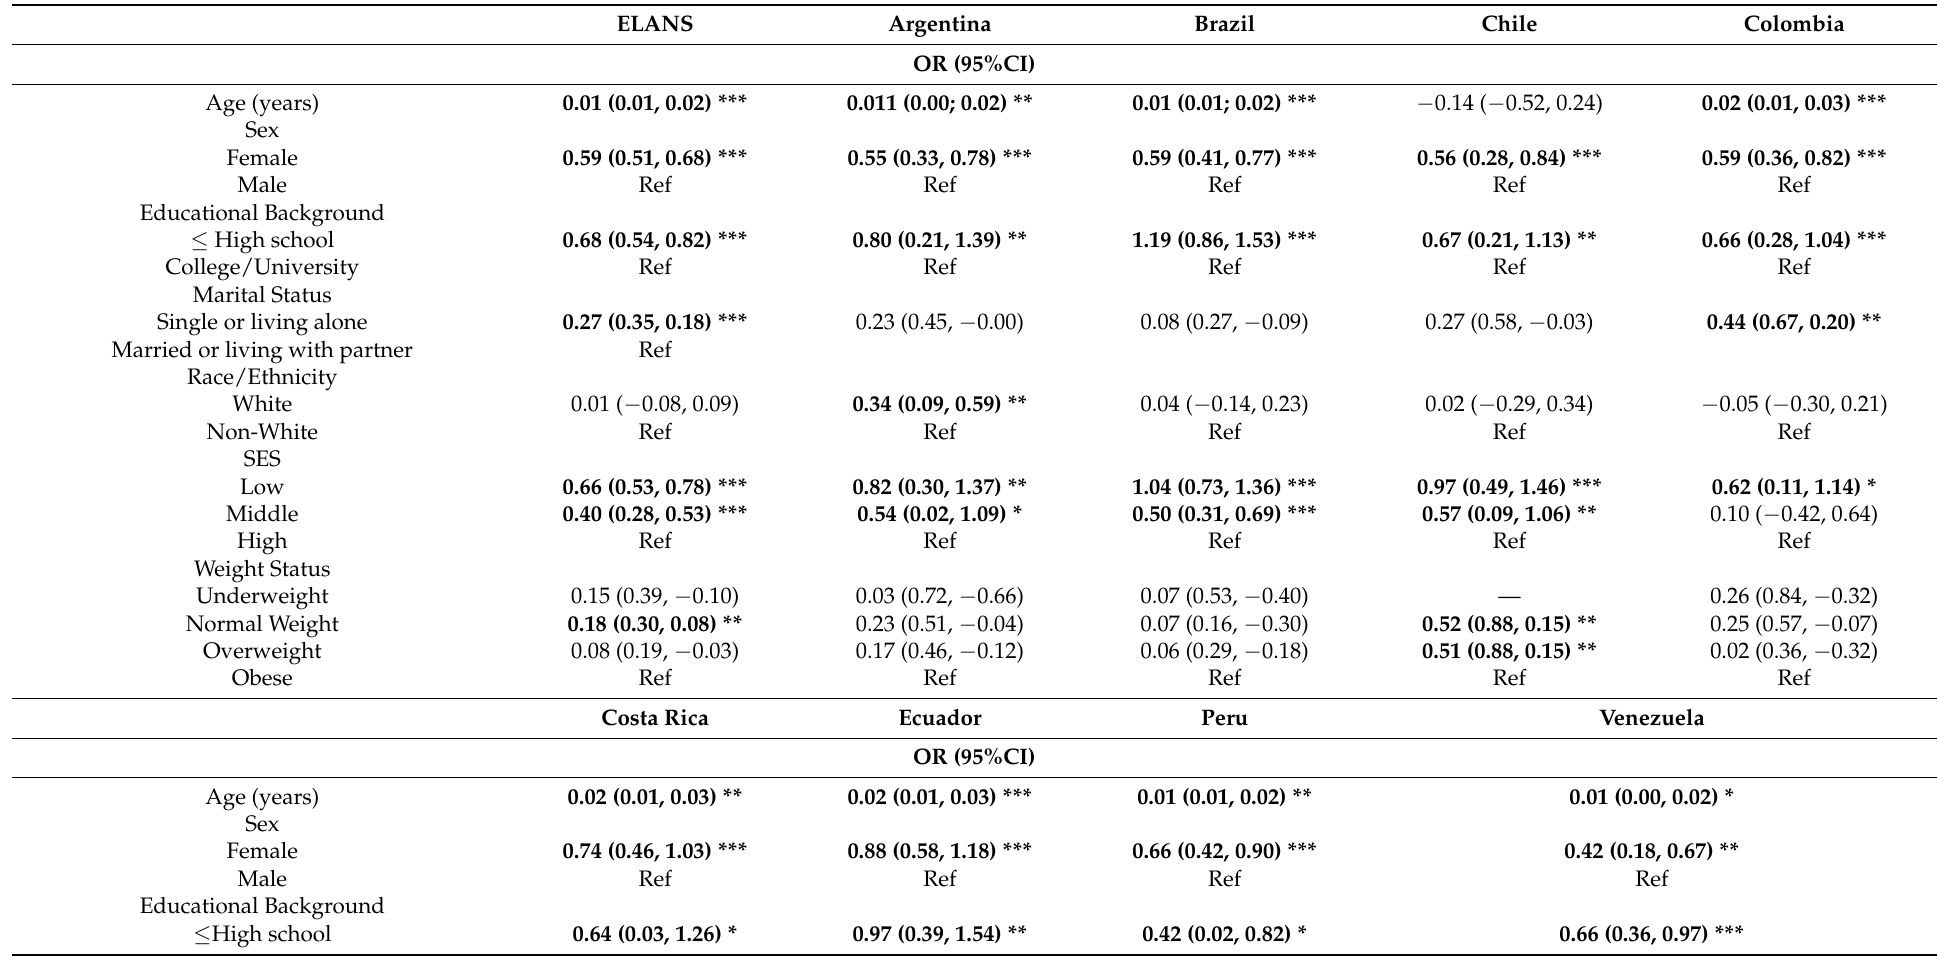
Table 3. Estimating association 1 with unhealthy behavior clustering across socio-demographic categories. The Latin American Health and Nutrition Study (ELANS) ( n =